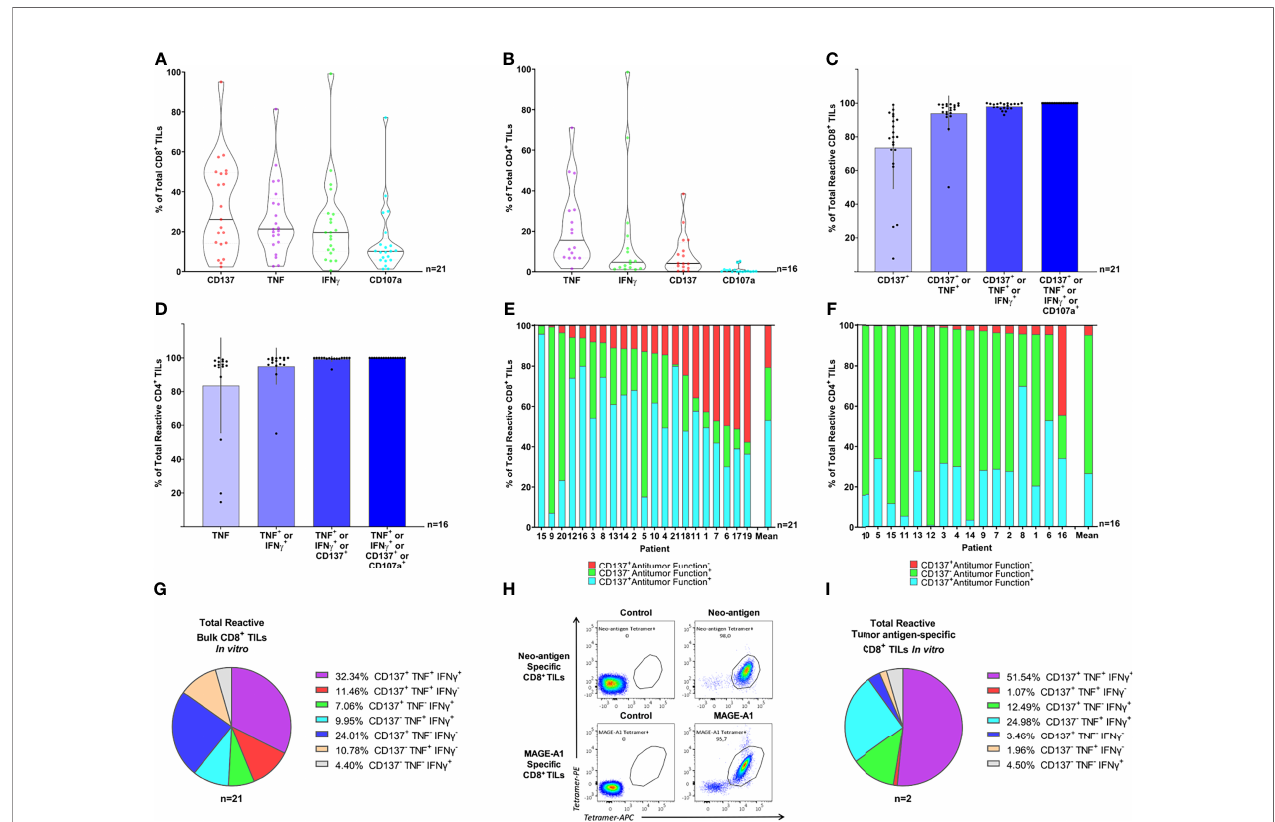
FIGURE 2 | Combined intracellular detection of CD137, TNF, and IFN g enhanced the detection of tumor-speci fi c reactive bulk TILs in vitro . (A, B) Violin plots illustrate the expression of CD137, TNF, IFN g , and CD107a in (A) CD8 + and (B) CD4 + TILs following 8 hours of co-culture with autologous TCLs, minus control (TILs alone). Individual markers are sorted by expression. Horizontal lines illustrate median values. (C, D) The relative individual contribution of the four markers analyzed (CD137, TNF, IFN g , and CD107a, summed in order of relevance) to the total (C) CD8 + and (D) CD4 + TIL tumor-speci fi c reactive population. Columns illustrate mean values and black bars represent standard deviations. Only cells expressing at least one of the four markers analyzed (CD137, TNF, IFN g , and CD107a) are displayed. (E, F) Relative distribution of each distinct sub-population identi fi ed via combined detection of CD137, TNF, IFN g , and CD107a within the (E) CD8 + and (F) CD4 + tumor-speci fi c reactive TIL repertoire after 8 hours of co-culture with autologous TCLs. TNF, IFN g , and CD107a were de fi ned “ Antitumor functions ” , therefore, TILs were de fi ned Antitumor Function + if staining positive for at least one of TNF, IFN g , and CD107a. Each bar represents an individual patient or the mean value. Only cells expressing at least one of the four markers analyzed (CD137, TNF, IFN g , and CD107a) are displayed. (G) Relative distribution of the seven combinations of the three markers of interest (CD137, TNF, and IFN g ) within “ bulk ” tumor-speci fi c reactive CD8 + TILs. Every pie chart slice represents a different combination of CD137, TNF, and IFN g . TILs were gated on cells expressing at least one of the three markers analyzed (CD137, TNF, and IFN g ). The pie chart illustrates mean values. (H) Neo-antigen-speci fi c CD8 + TILs (upper panel) and MAGE-A1-speci fi c CD8 + TILs (lower panels) from two distinct patients were sorted based on 2-color tetramer binding and expanded in vitro followed by tetramer staining showing high speci fi city (>95%) for the autologous tumor-antigens. (I) The pie chart illustrates the relative distribution of the seven combinations of the three markers of interest (CD137, TNF, and IFN g ) within tumor-speci fi c reactive CD8 + TILs, from pure tumor antigen-speci fi c CD8 + TILs. Each pie chart slice represents a different combination of CD137, TNF, and IFN g . Bulk TILs or enriched CD8 + and CD4 + bulk TILs were used to obtain the intracellular staining data presented in panel A-G (19 MM, 1 OC and 1 SAR samples for CD8 + TILs and 16 MM samples for CD4 + TILs) and only samples with high percentage of tumor-reactive TILs were selected for these analyses. Two pure CD8 + TIL samples speci fi c for known autologous tumor-antigens (MM) were used to obtain the fl ow cytometry data presented in panel H (tetramer staining) and I (intracellular staining). The CD137 + TNF - IFN g - population represented 24% of the bulk tumor-speci fi c reactive CD8 + TILs. This suggested that the use of CD137 improved the detection of “ bulk ” tumor-speci fi c reactive CD8 + TILs compared to the combination of TNF and IFN g . The use of CD107a did not add value to the overall signi fi cance of the assay. The optimized detection of tumor- speci fi c reactive TILs identi fi es multiple functional clusters of tumor-speci fi c reactive TILs both in “ bulk ” and pure tumor antigen-speci fi c CD8 + TILs in vitro